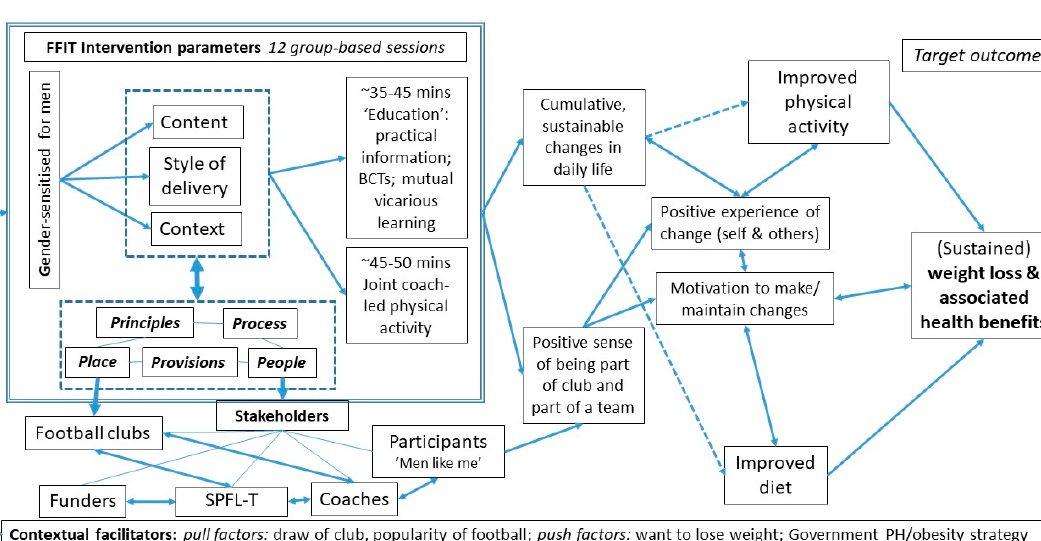
Figure 1. A simplified theory of change for FFIT, showing core components and mechanisms of action in relation to the PRACTIS framework. Footnote: Detail on BCTs, further elucidation of mechanisms of action are available elsewhere [8,10,12,13,25,43,44].